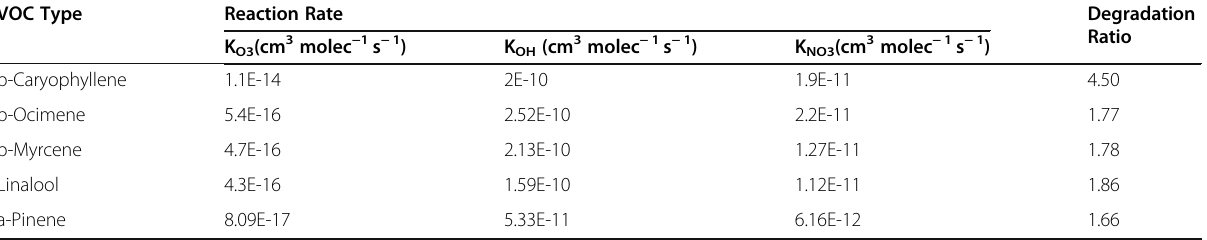
Table 2 The calculated degradation ratios (nature/roadside) of the five floral VOCs